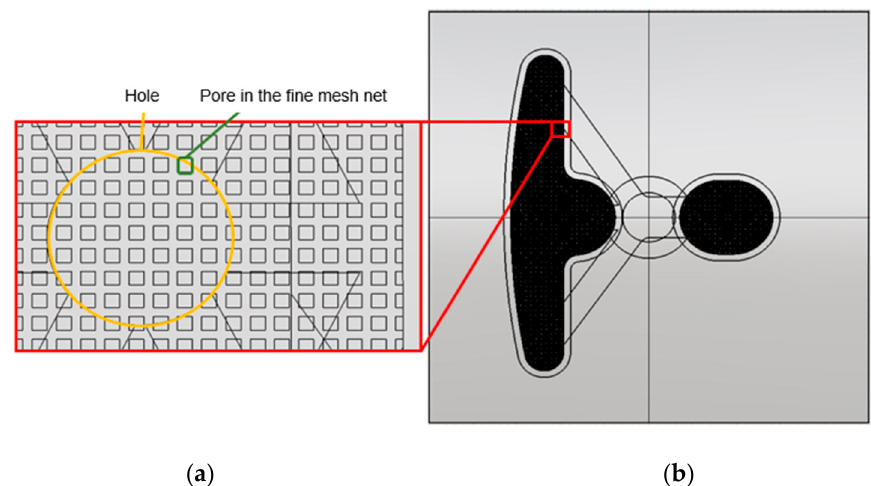
Figure 6. The design of the fine mesh nets. ( a ) Illustration of partial enlargement of fine mesh and ( b ) top view of the design of the fine mesh nets.